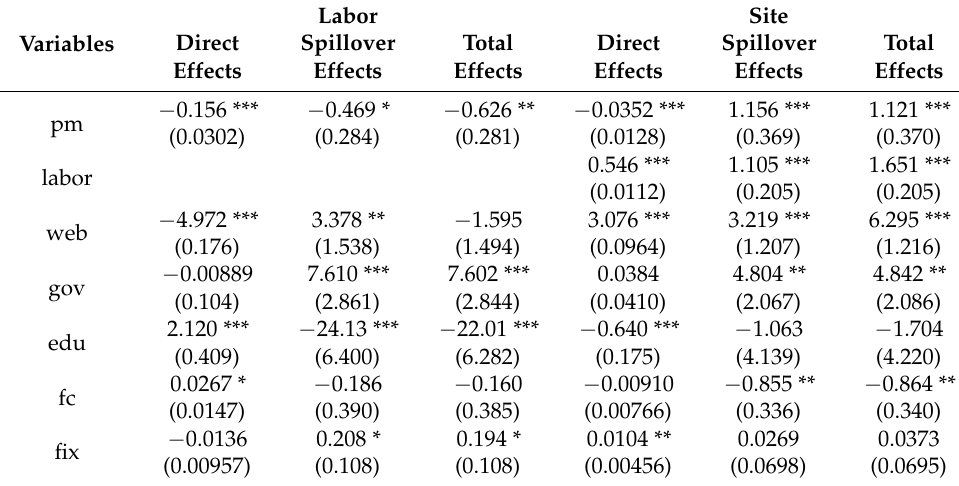
Table 11. Mechanism analysis with labor endowment effect.